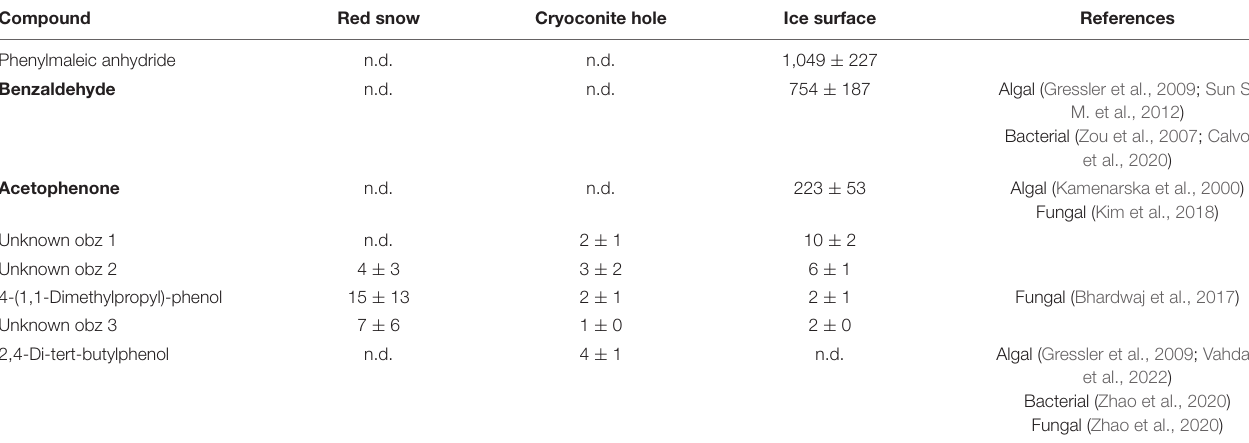
Compound Red snow Cryoconite hole Ice